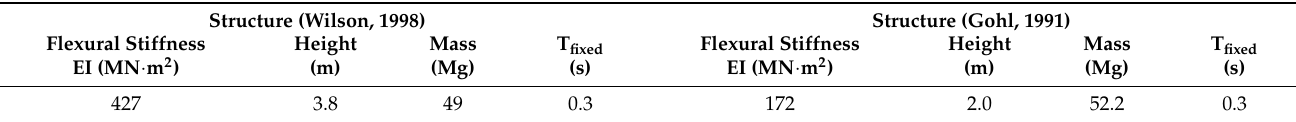
Table 2. The superstructure properties in the verification analyses.